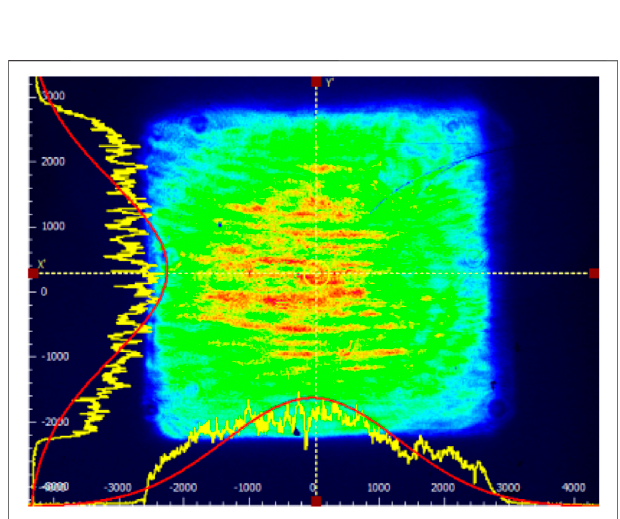
FIGURE 8 | Far fi eld of the laser beam (A) before compensation and (B) after compensation.